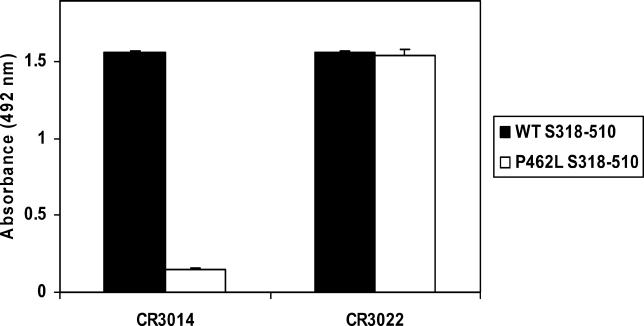
Binding of mAbs CR3014 and CR3022 to Recombinant Wild-Type and P462L-Substituted S318–510 Fragments Analyzed by ELISABars represent the means ± standard deviation.